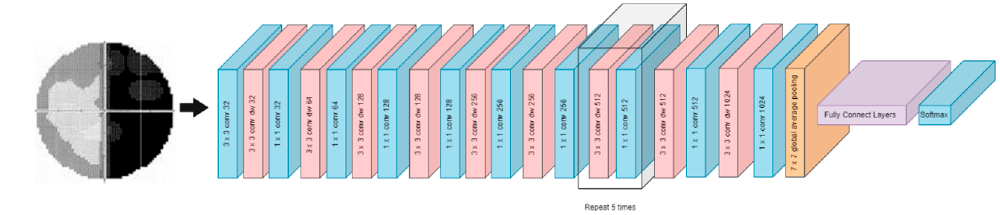
Figure 6. MobileNet Model.